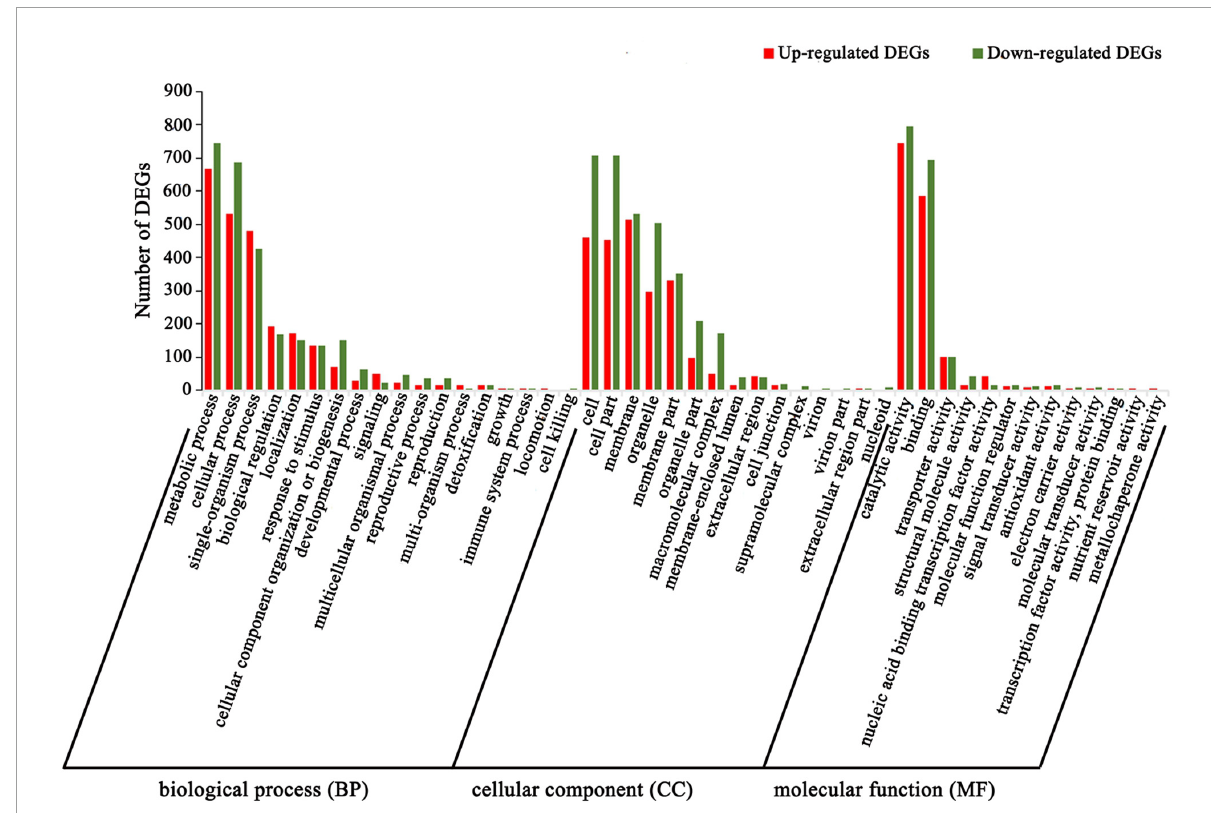
FIGURE4 GO enrichment of DEGs in Trp + S + MeJA-treated and non-treated PLBs of D. officinale . The x -axis indicates the percentage of DEGs in the subcategories of each main category. The y -axis indicates the number of DEGs in each subcategory.